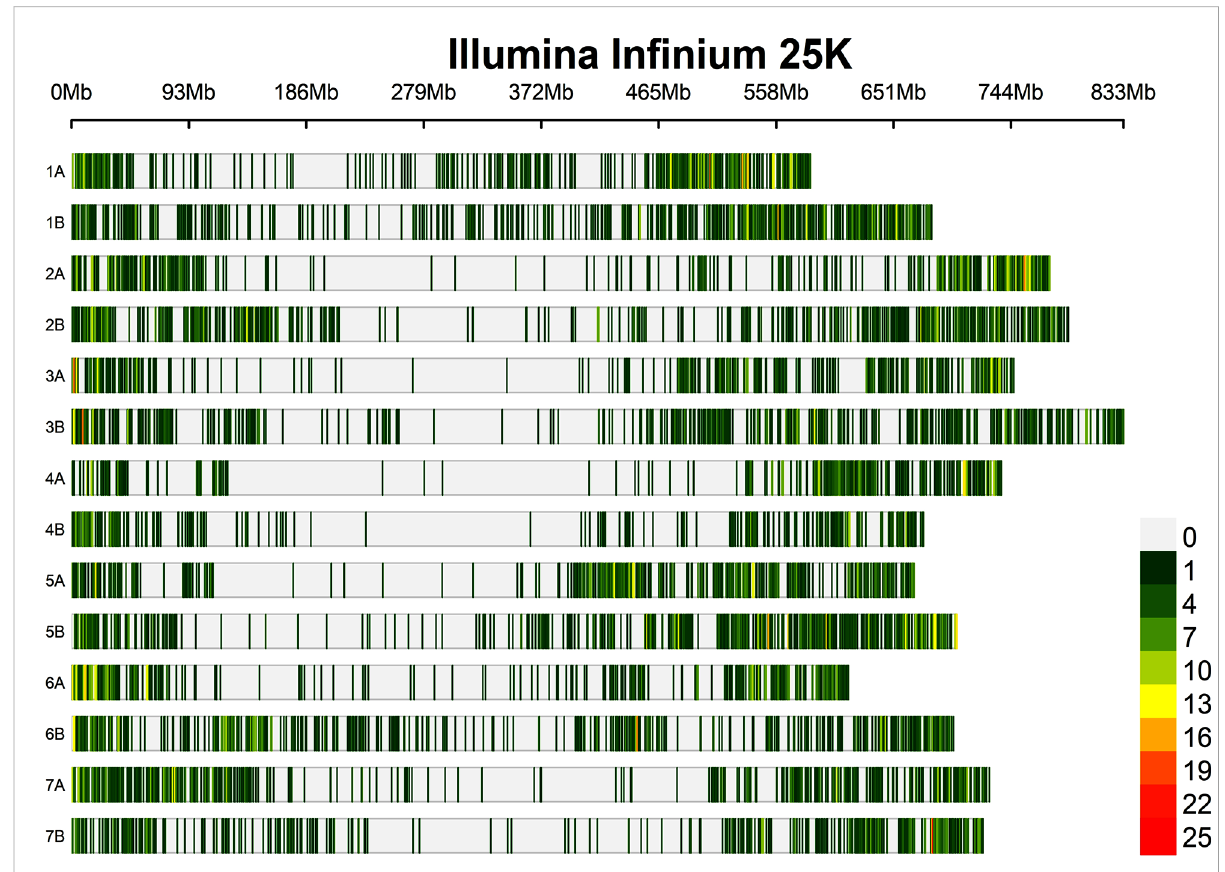
FIGURE 3 Distribution of the SNPs used in the present study on each durum wheat